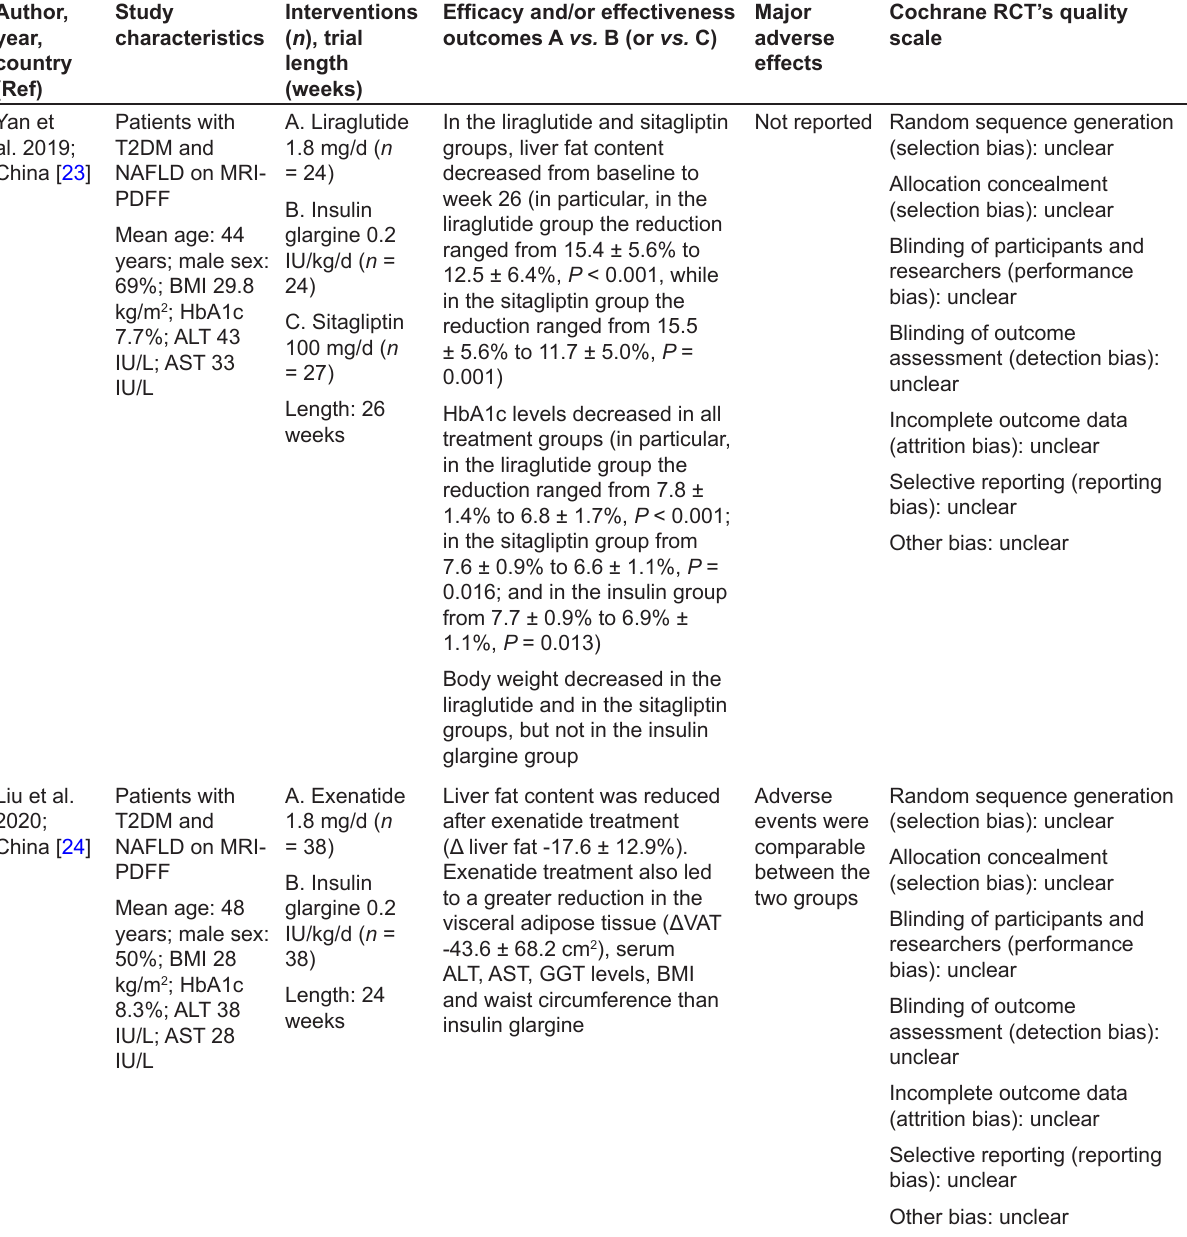
Table 1 . Placebo-controlled or active-controlled RCTs of GLP-1 RAs for treatment of NAFLD or NASH (ordered by publication year) ( continued